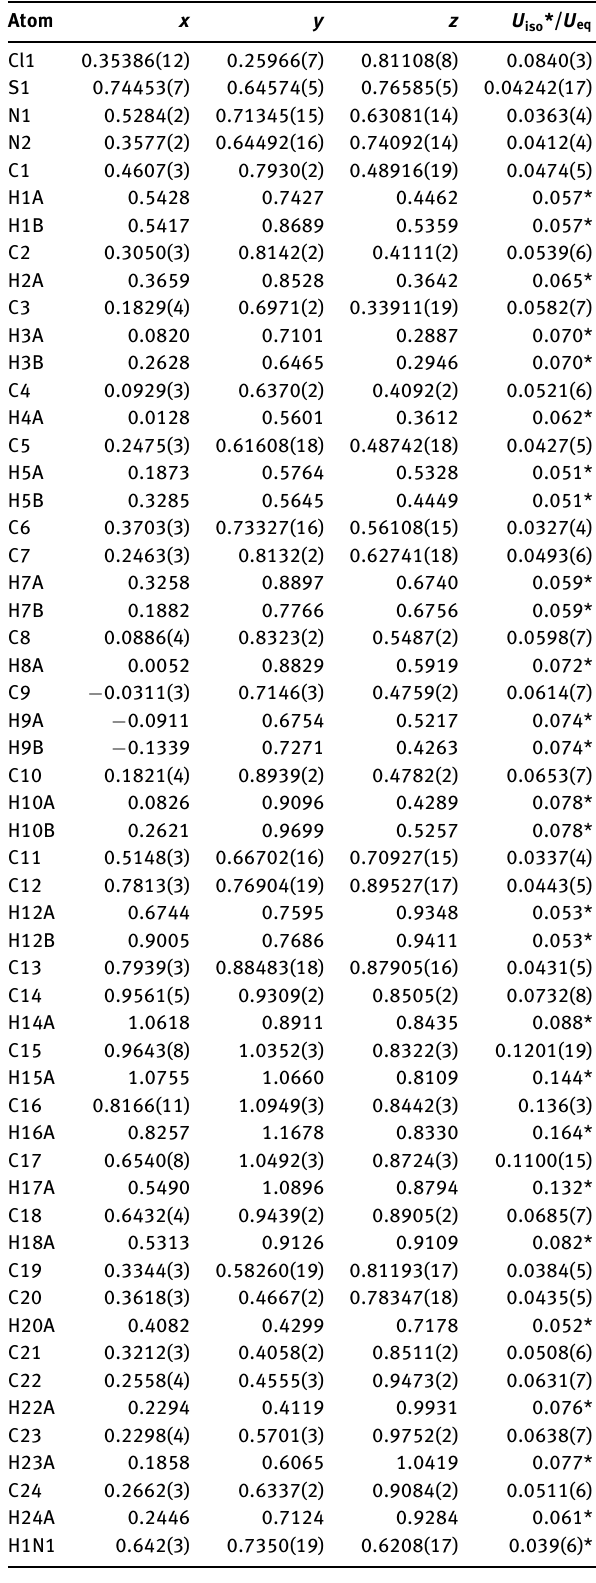
Table 2: Fractional atomic coordinates and isotropic or equivalent isotropic displacement parameters (Å 2